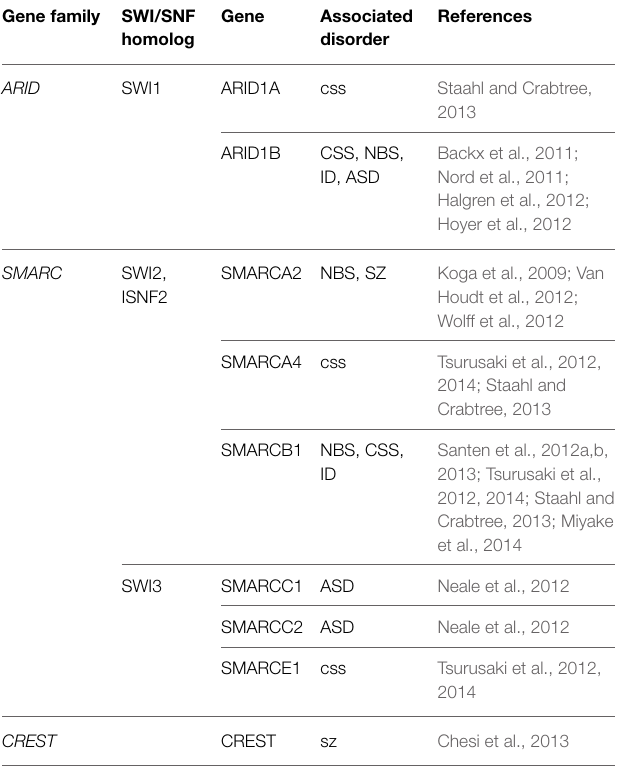
TABLE 1 | BAF subunit coding genes implicated in neurological disorders.